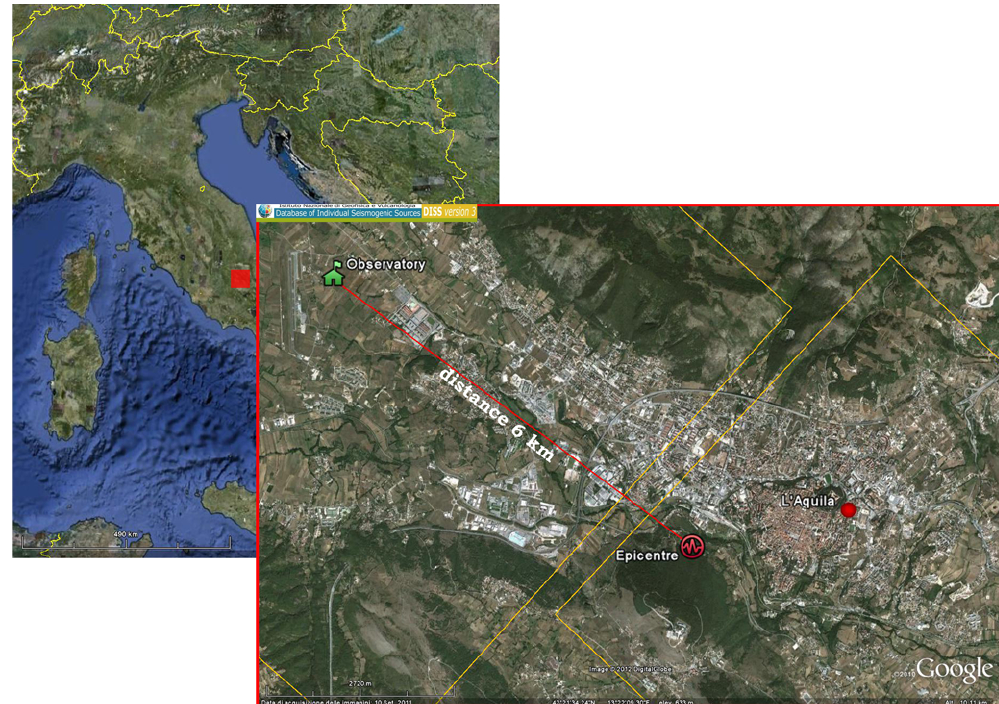
Fig. 1. Location of L’Aquila geomagnetic observatory with respect to the city of L’Aquila and the main shock epicentre. The instruments are located approximately 6km from the estimated epicentre. The figure also shows some known fault structures near L’Aquila (yellow lines indicate fault plane projections), as extracted from the INGV DISS ver. 3 database (http://diss.rm.ingv.it/dissNet/) (Basili et al., 2008; DISS Working Group,